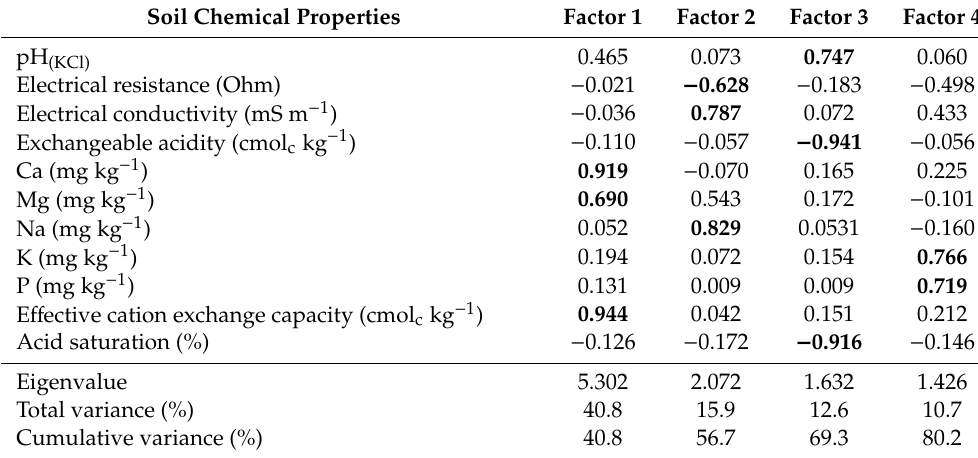
Table 2. Principal component extraction using factor analysis. Varimax-normalised factor loadings for soil chemical properties across the Western Cape crop production region in South Africa are presented, along with the eigenvalue, total variance, and cumulative variance. Boldfaced values indicate the highest loading of each soil attribute, therefore forming part of a particular factor.